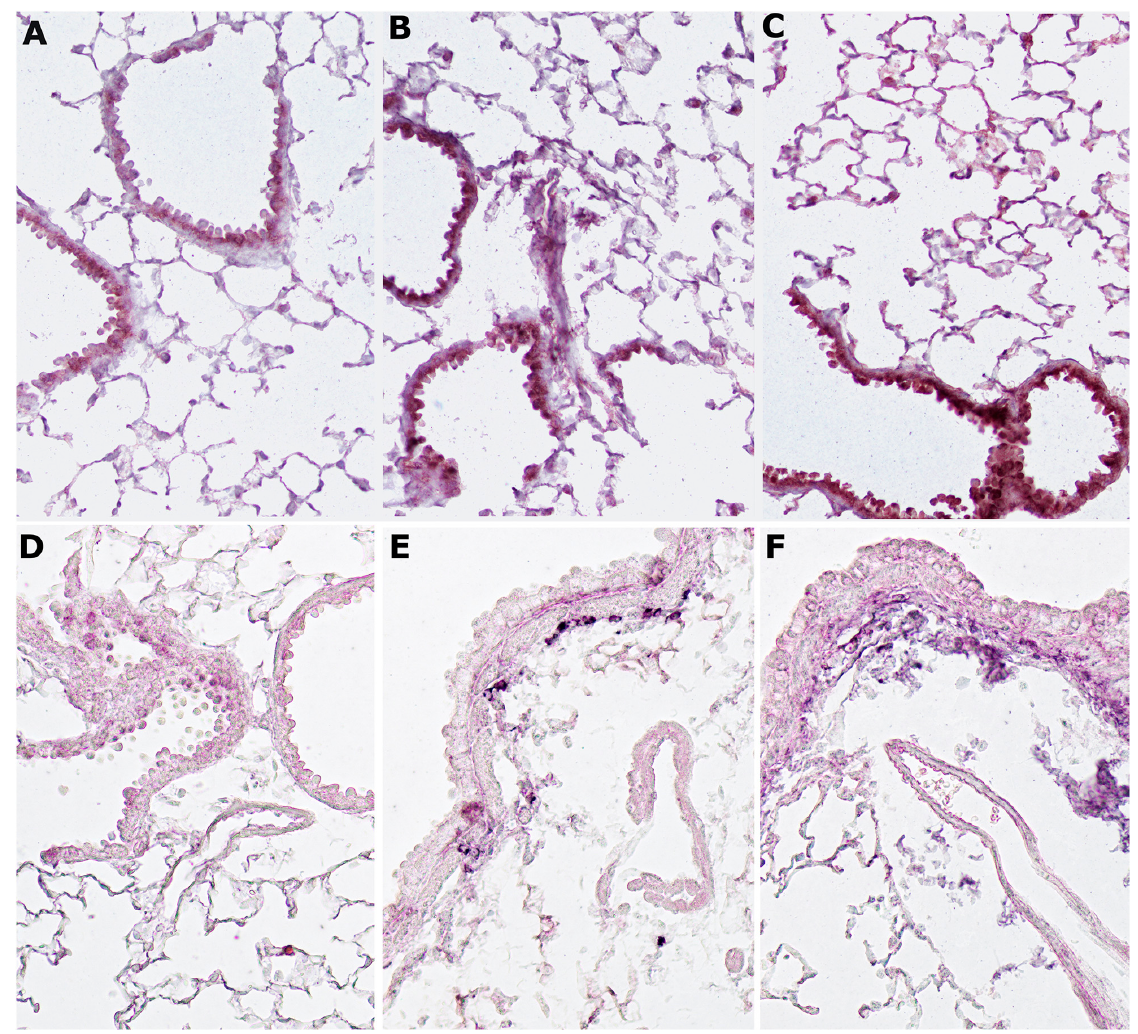
Figure 4. Expression of p38 MAPK and pSer10 phosphorylation after cigarette smoke: ( A ) The immunoreaction for p-p38 is weak and not noticeable in several lung areas of control mice exposed to room air; ( B ) an immunohistochemical positive reaction for p-p38 can be appreciated in lung tissue from smoking mice on airway epithelial cells and type II alveolar cells; ( C ) the reaction for this MAP kinase is also very clear on lung structures of mice that have quit smoking; ( D ) a very weak reaction for pSER10 is present in the lungs of control mice exposed to room air; ( E , F ) a strong reaction for pSer10 is present on sub-bronchial inflammatory cells and peripheral peri-bronchial areas of smoking mice ( E ) and in lungs from mice left to rest in room air after 4 months of CS exposure ( F ). ( A – F ), ×200. 2.6. Neutrophilic Inflammation Is Accompanied by Intense Staining for Neutrophil Elastase, Metalloprotease 9 (MMP-9), and 8-Oxo-7,8-Dihydro-2 ′ -Deoxyguanosine (8-OHdG)